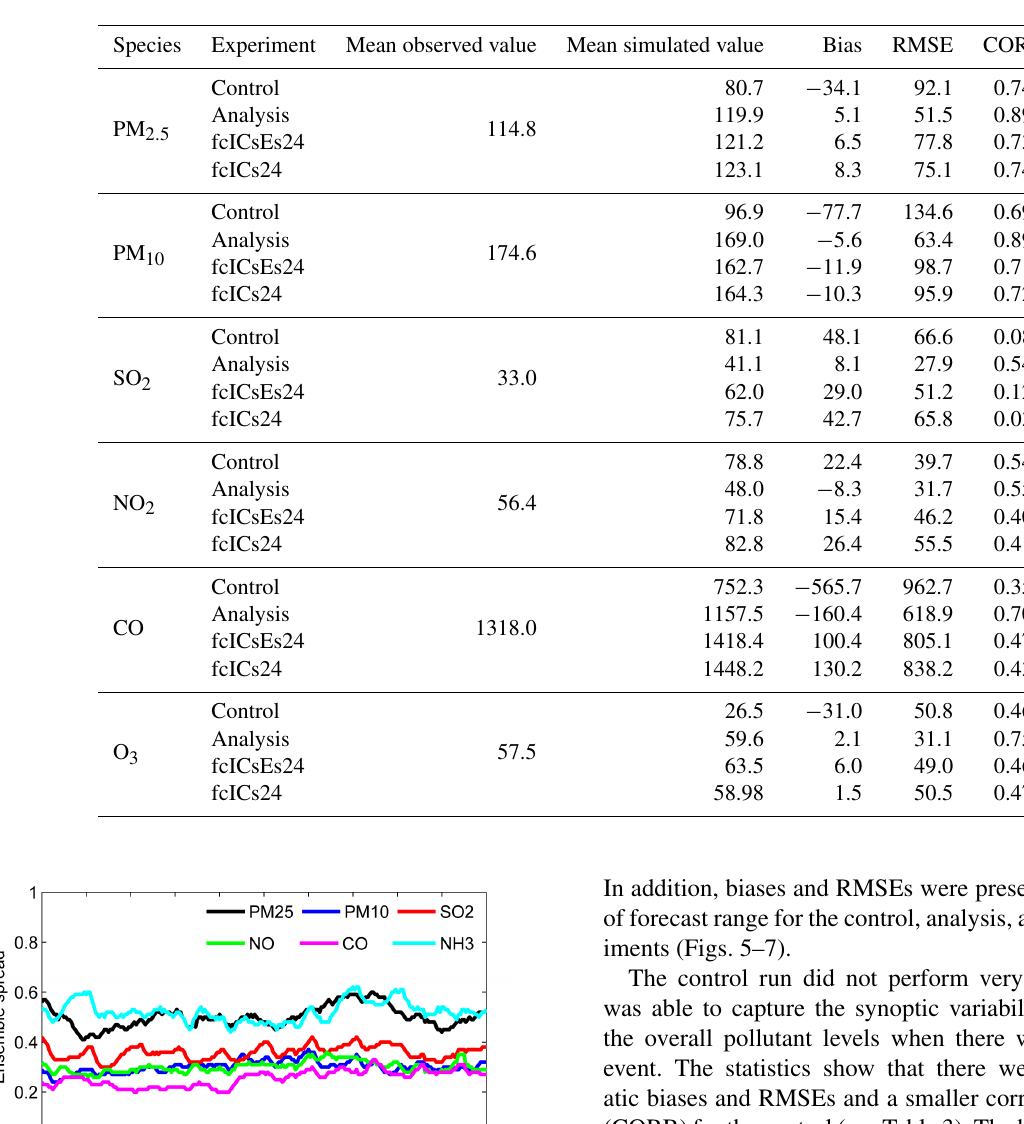
Table 3. Comparison with observations of the surface PM 2 . 5 mass concentrations in the Beijing–Tianjin–Hebei region from the control experiment, the assimilation experiment, and the first-day forecast, over all analysis times from 6 to 16 October 2014. Units: µgm − 3 .